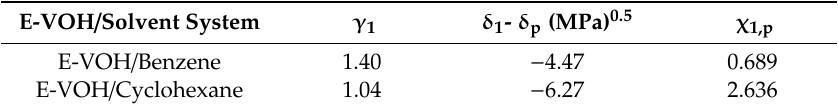
Table 4. Values of the activity coe ffi cients of the solvents and Flory interaction parameters of the E-VOH / benzene and E-VOH / cyclohexane